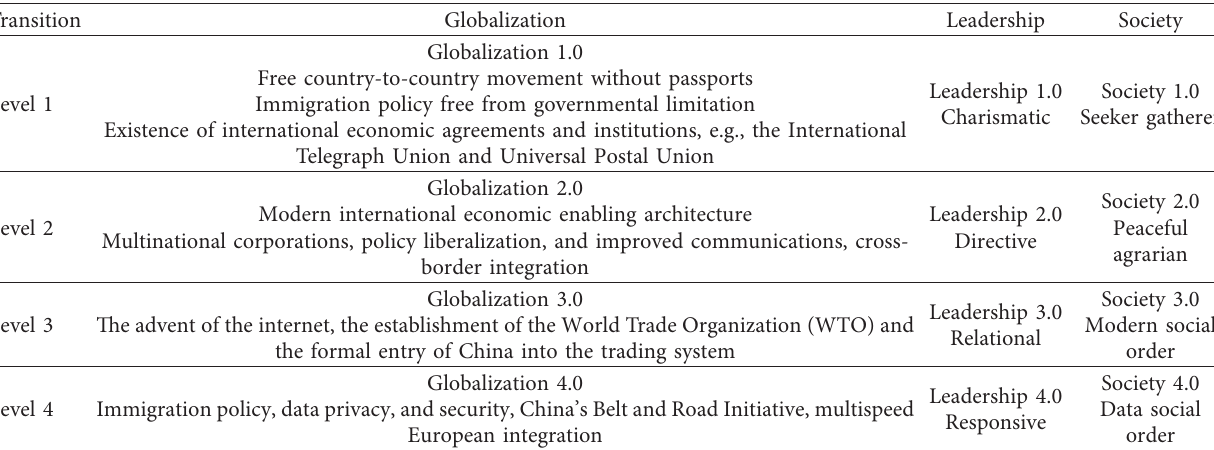
Table 11: The transition in globalization, leadership, and